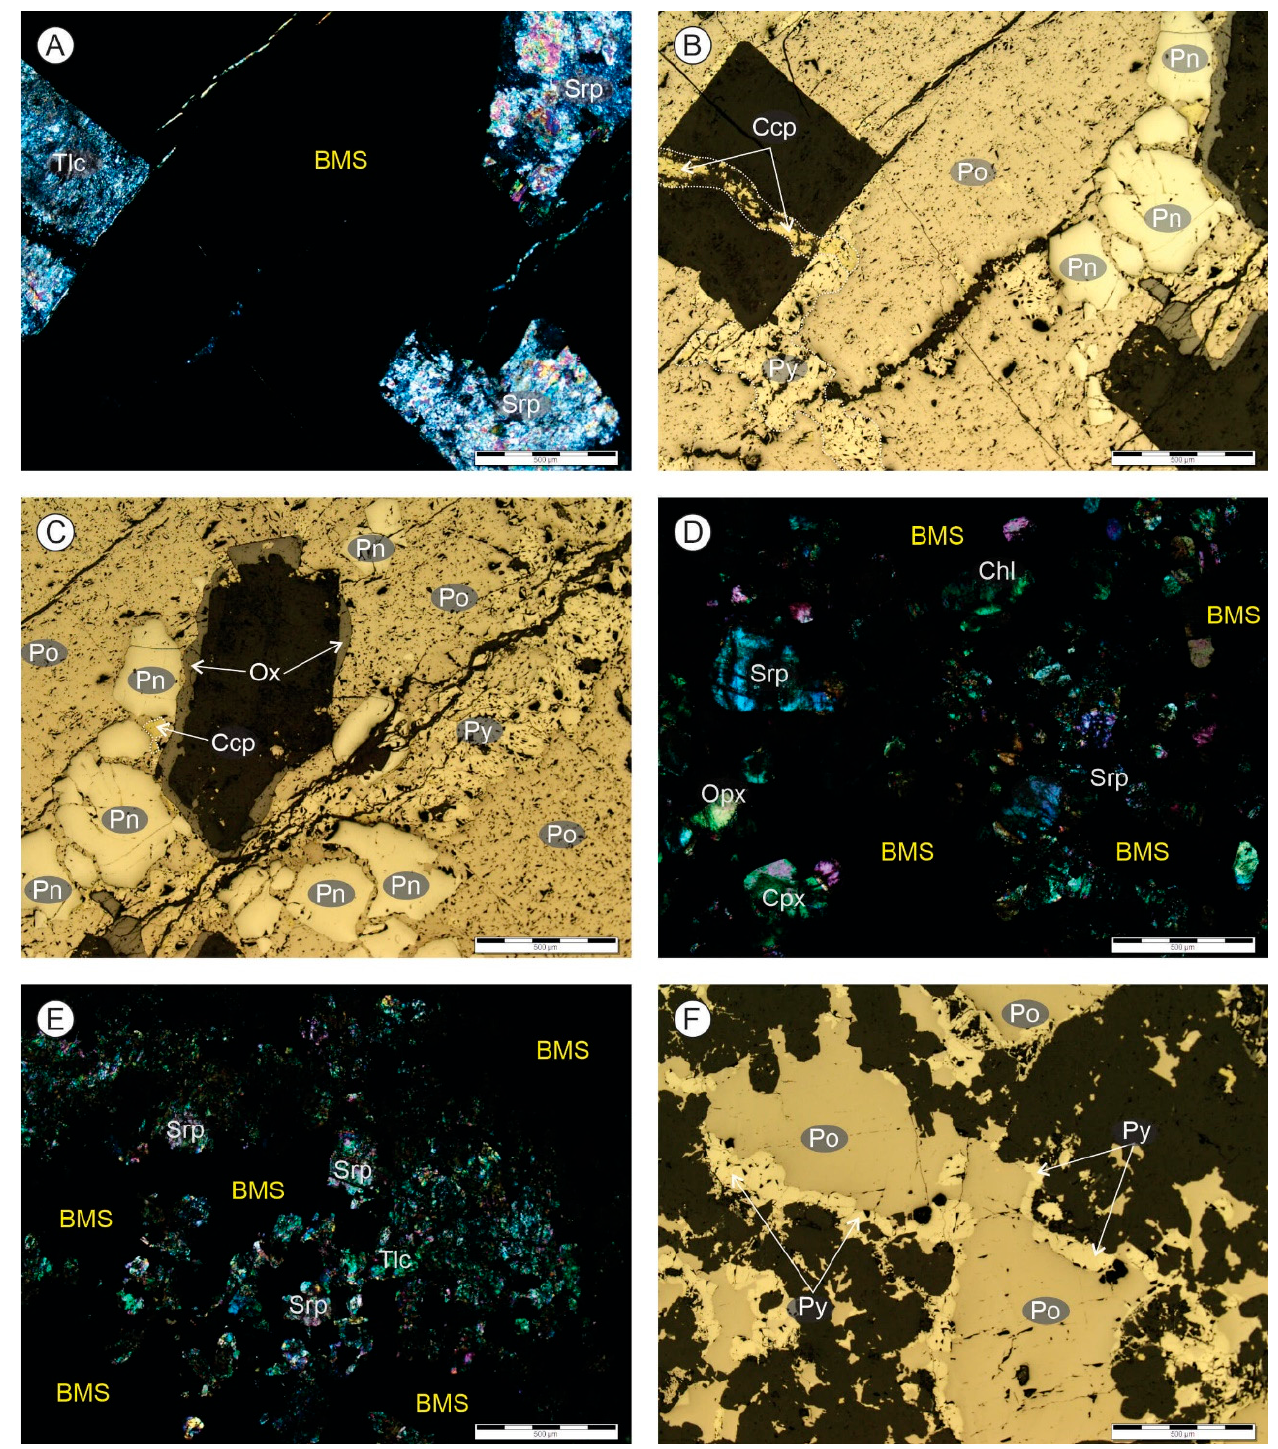
Figure 4. Photomicrographs of the high-grade massive sulfide ores ( A – C ) as well as the medium- grade massive sulfide ores ( D – F ) show various silicates and composite sulfides. The scale bar at the bottom right corner of the images represents 500 µm. Refer to Figure 2 for explanation of the mineral abbreviations.